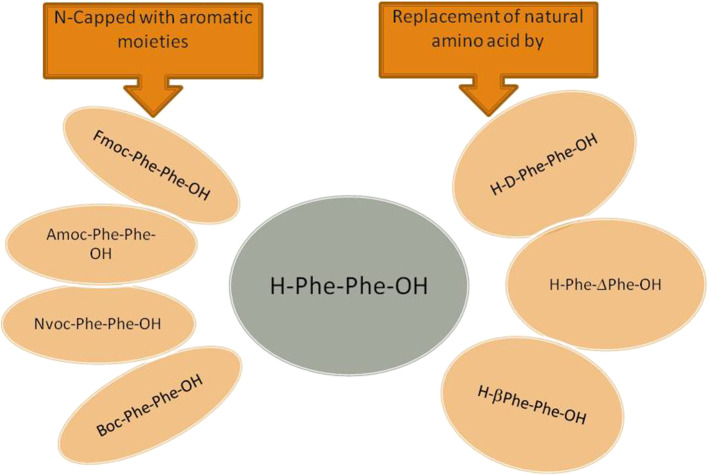
Some of the analogs of H-Phe-Phe-OH.